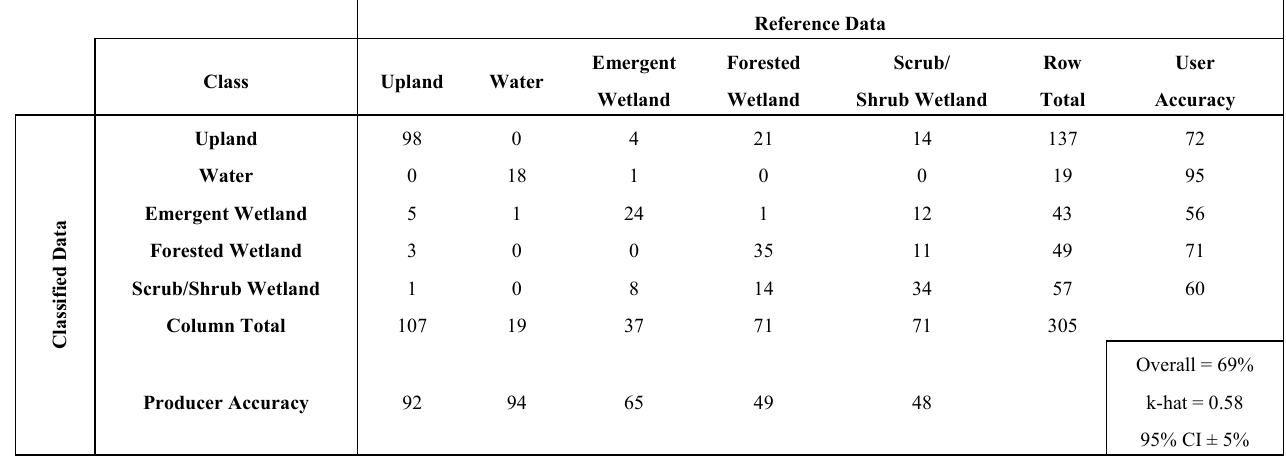
Table 9. Classification error matrix for the most accurate full season random forest model for the Level 2 classification which incorporated all available Landsat 5 TM, aerial orthophoto, topographic, RADARSAT-2, PALSAR, and soils data.